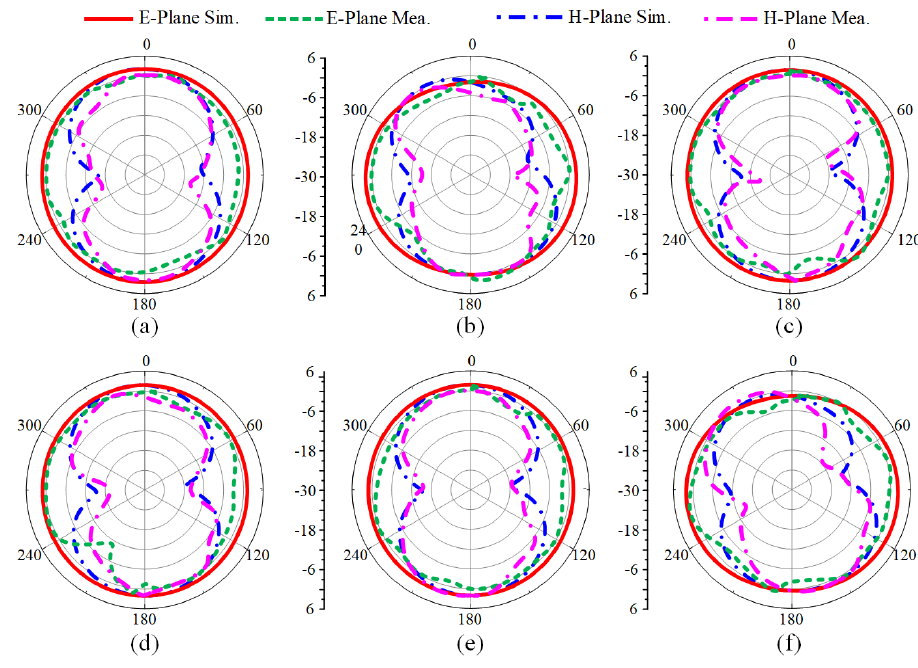
Figure 7. Simulated and measured radiation pattern ( a ) case-00 ( b ) case-00 ( c ) case-01 ( d ) case-10 ( e ) case-11 ( f )